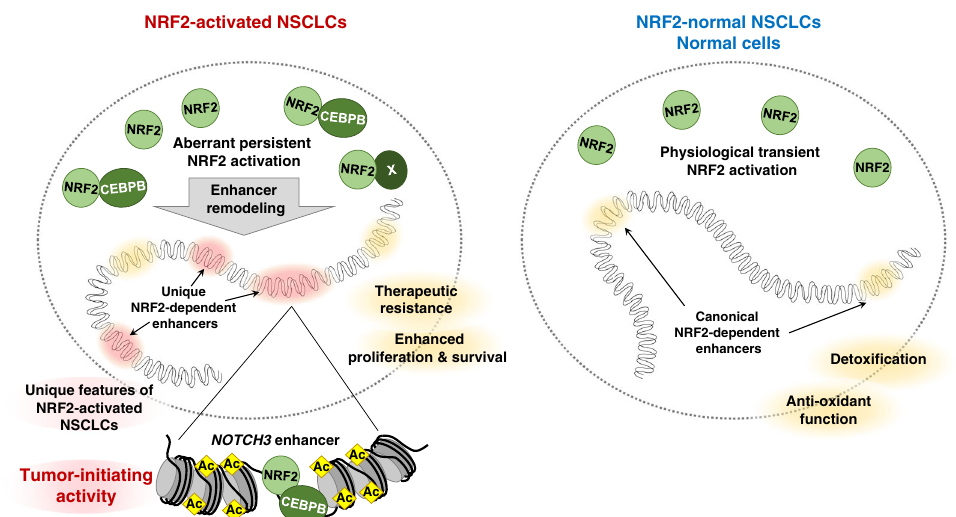
Fig. 10 Illustration of enhancer remodeling in NRF2-activated NSCLCs. Under physiological conditions and in NRF2-normal NSCLCs, NRF2 is transiently activated in response to stimuli and induces canonical enhancer formation to activate genes involved in detoxi fi cation and antioxidant function (right). The canonical enhancers are regarded to confer therapeutic resistance and promote cell proliferation and survival. In NRF2-activated NSCLCs, enhancer remodeling creates unique NRF2-dependent enhancers (left). CEBPB is one of the cooperative factors for NRF2 that mediates enhancer remodeling. The NOTCH3 enhancer, one of the unique enhancers, promotes tumor-initiating